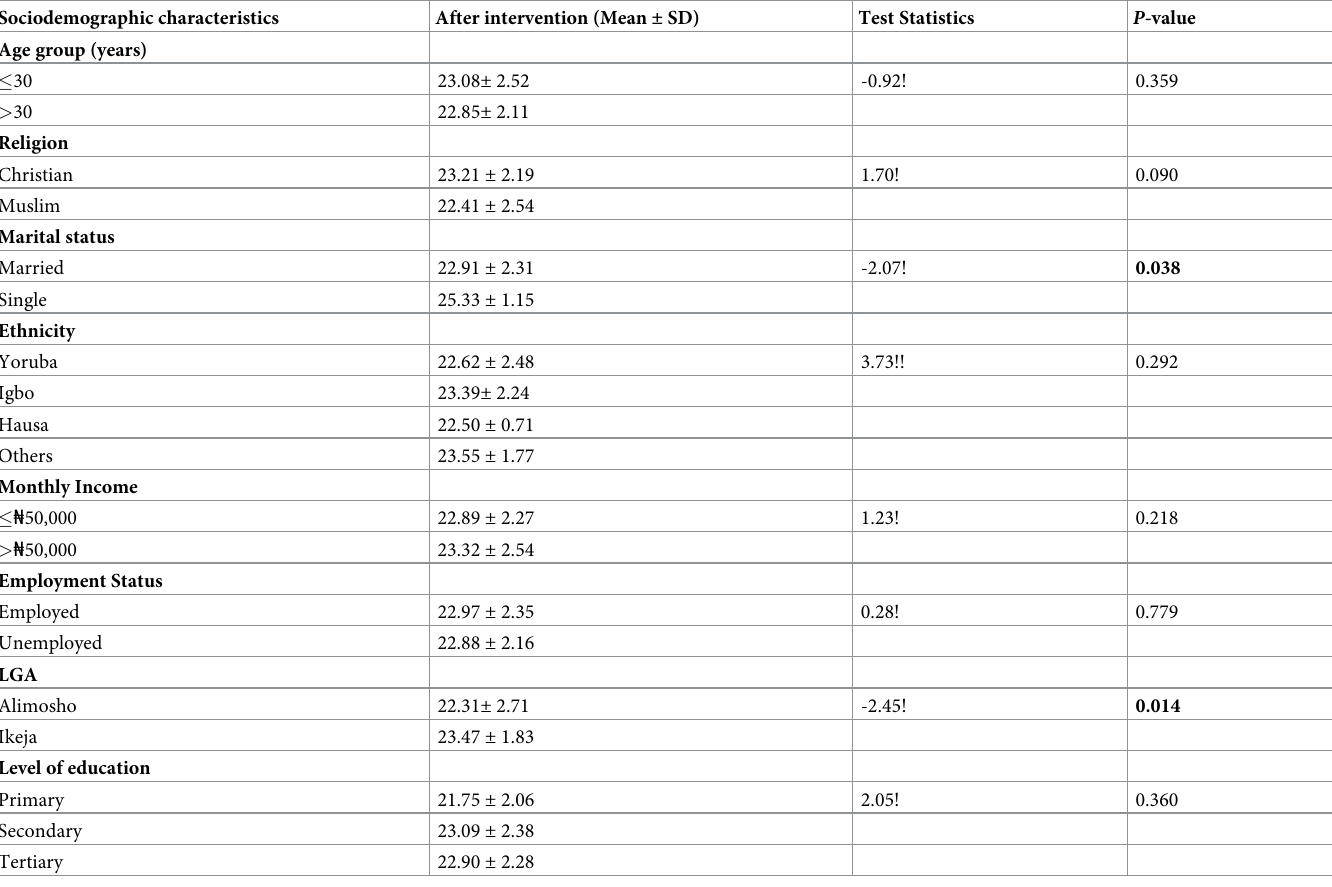
Table 9. Association between the socio-demographic characteristics of clients and knowledge scores after interaction with trained PHC workers. Sociodemographic